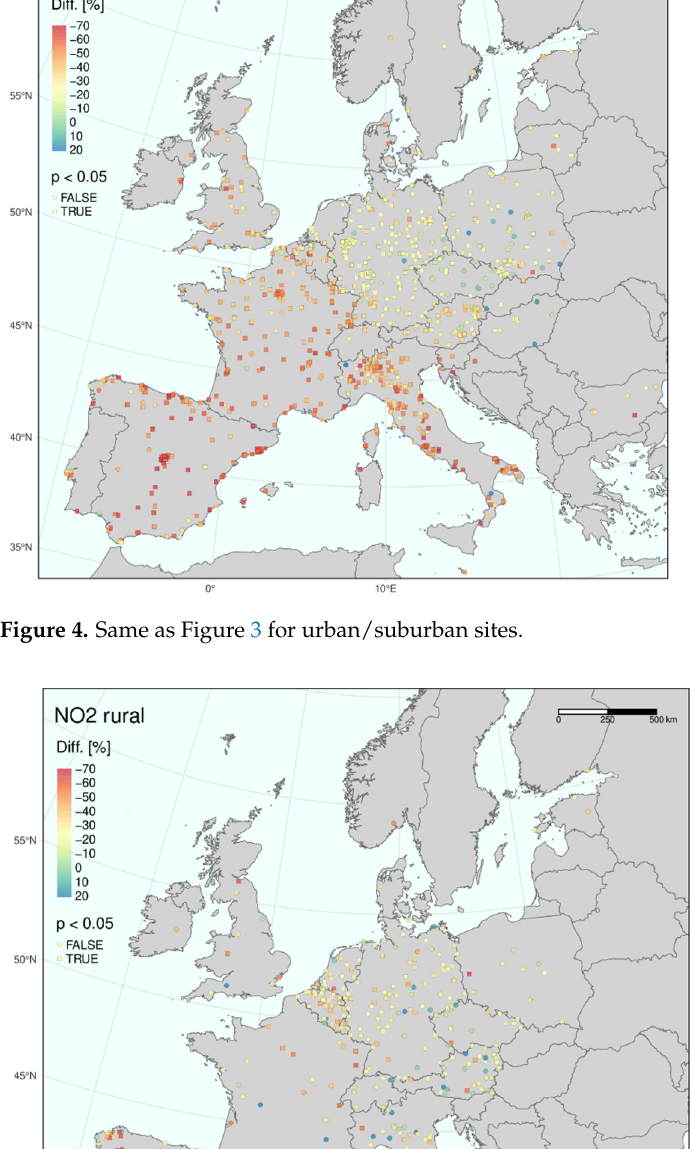
Figure 5. Same as Figure 3 for rural sites.